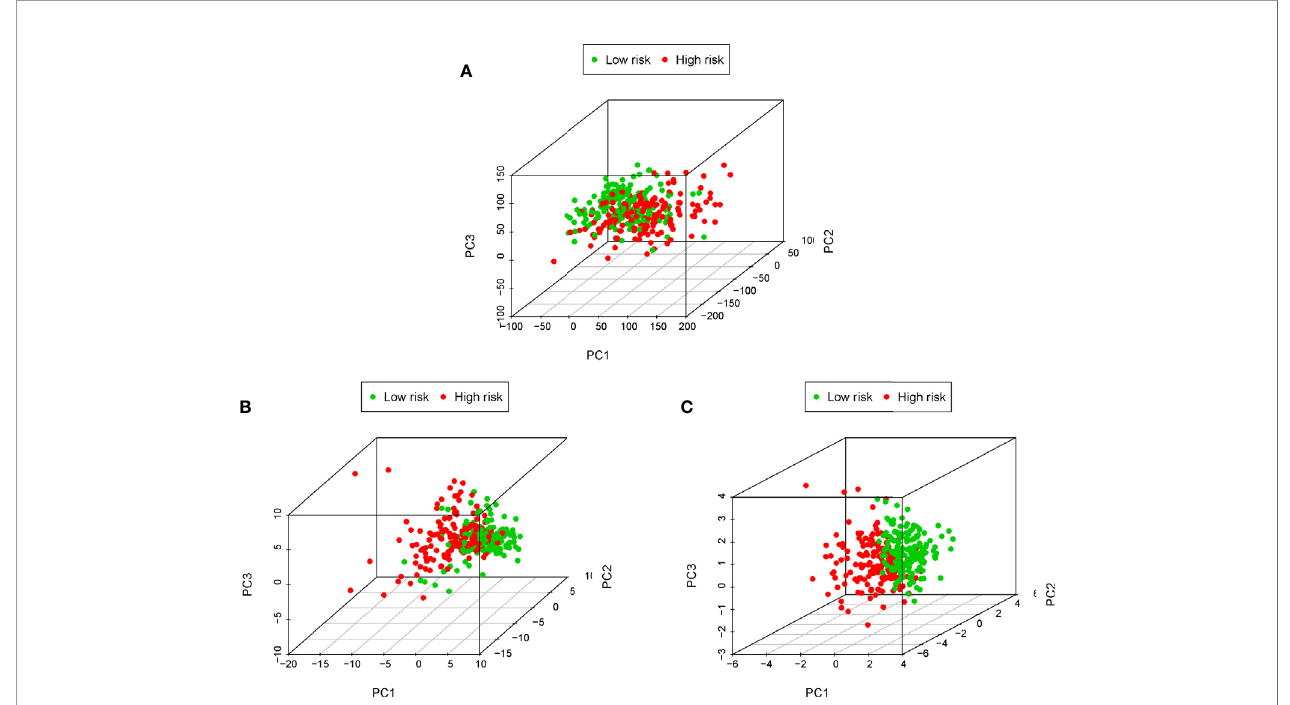
FIGURE 5 | PCA analysis of each genome in the TCGA cohort. PCA analysis based on the entire genome expression pro fi le (A) , the all genes related to ERS (B) and risk model genome (C)